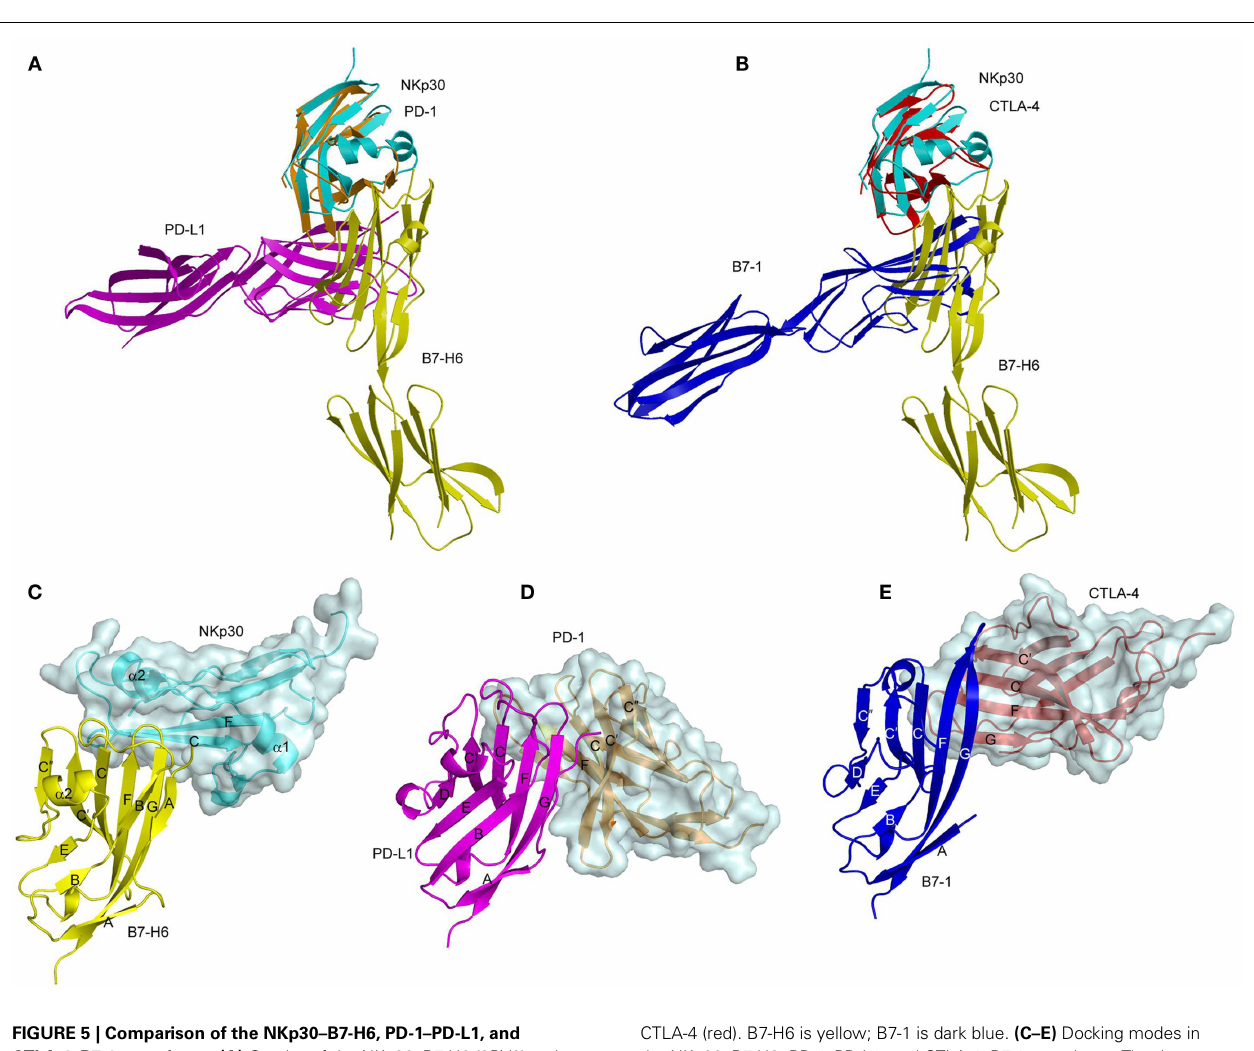
FIGURE 5 | Comparison of the NKp30–B7-H6, PD-1–PD-L1, and CTLA-4–B7-1 complexes . (A) Overlay of the NKp30–B7-H6 (3PV6) and PD-1–PD-L1 (3BIK) complexes by superposing NKp30 (cyan) onto PD-1 (brown). B7-H6 is yellow; PD-L1 is violet. (B) Overlay of the NKp30–B7-H6 and CTLA-4–B7-1 (1I8L) complexes by superposing NKp30 (cyan) onto